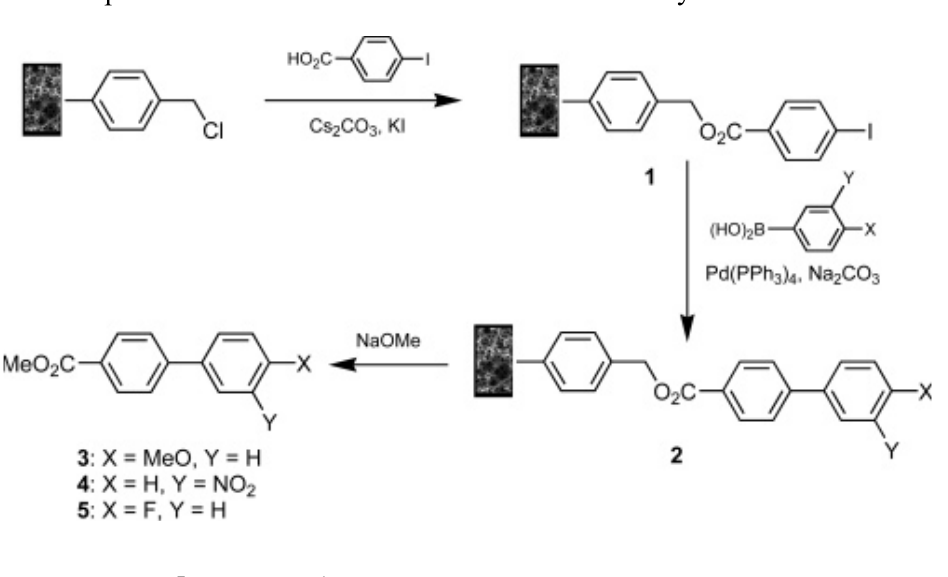
Figure 10. PolyHIPE-supported synthesis of biphenyl-4-carboxylic acid methyl esters [136]. Reprinted with permission from the American Chemical